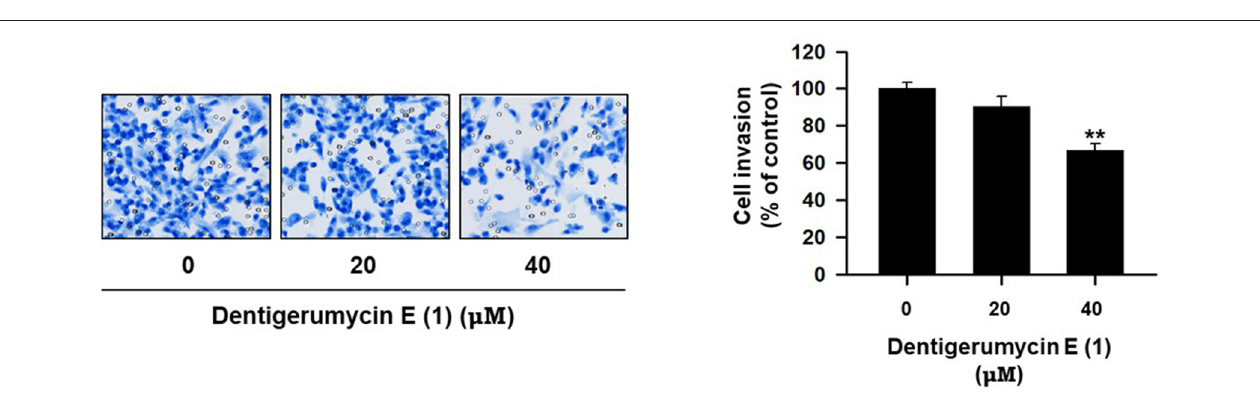
FIGURE 8 | Dentigerumycin E suppresses cell invasion of the human breast cancer cell line (MDA-MB-231) in the cell invasion assay. The data are represented as the means ± SD from three independent experiments: ** p < 0.01.